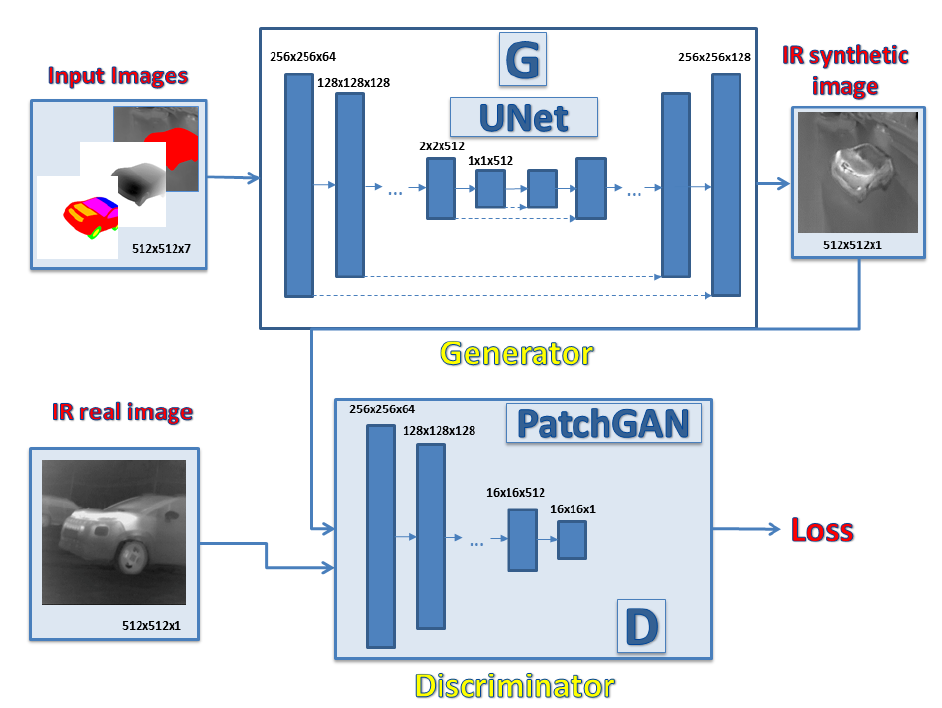
Figure 4. The proposed method for infrared image synthesis